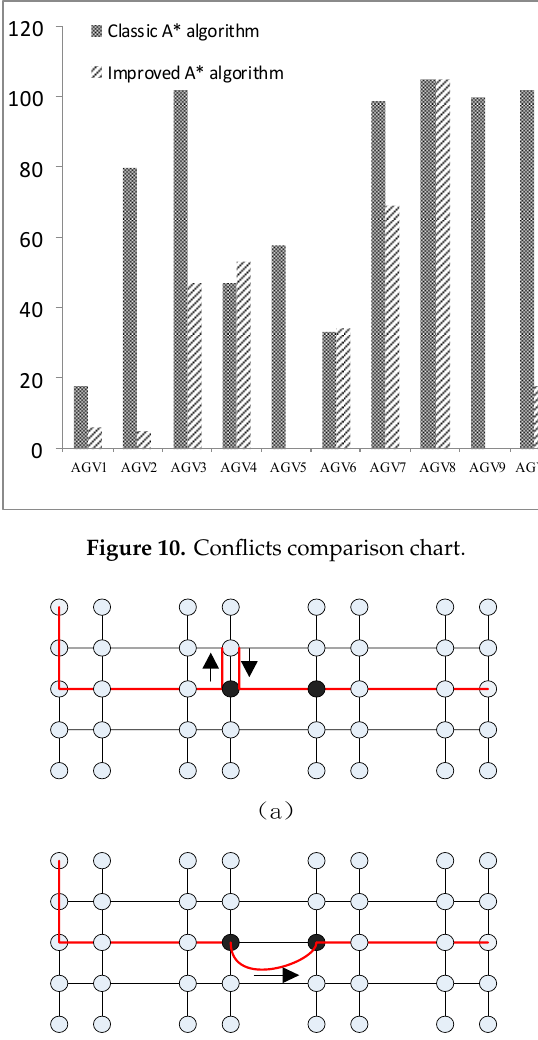
Figure 10. Conflicts comparison chart.